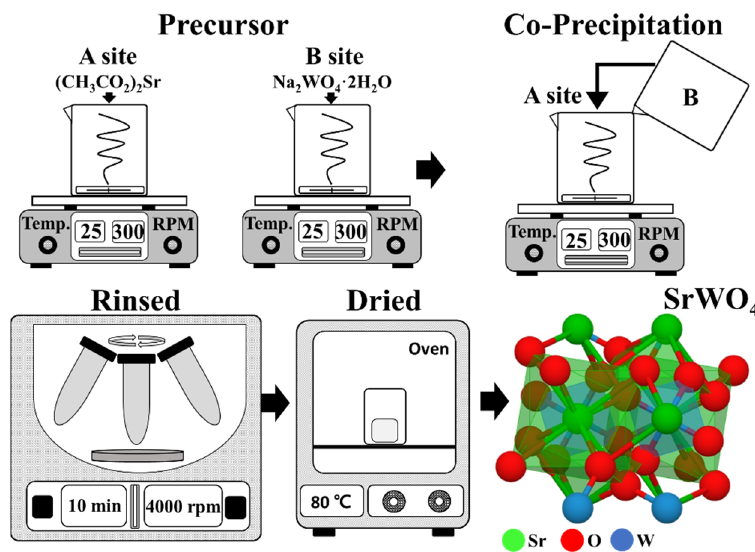
Figure 1. Schematic of co-precipitation procedure.